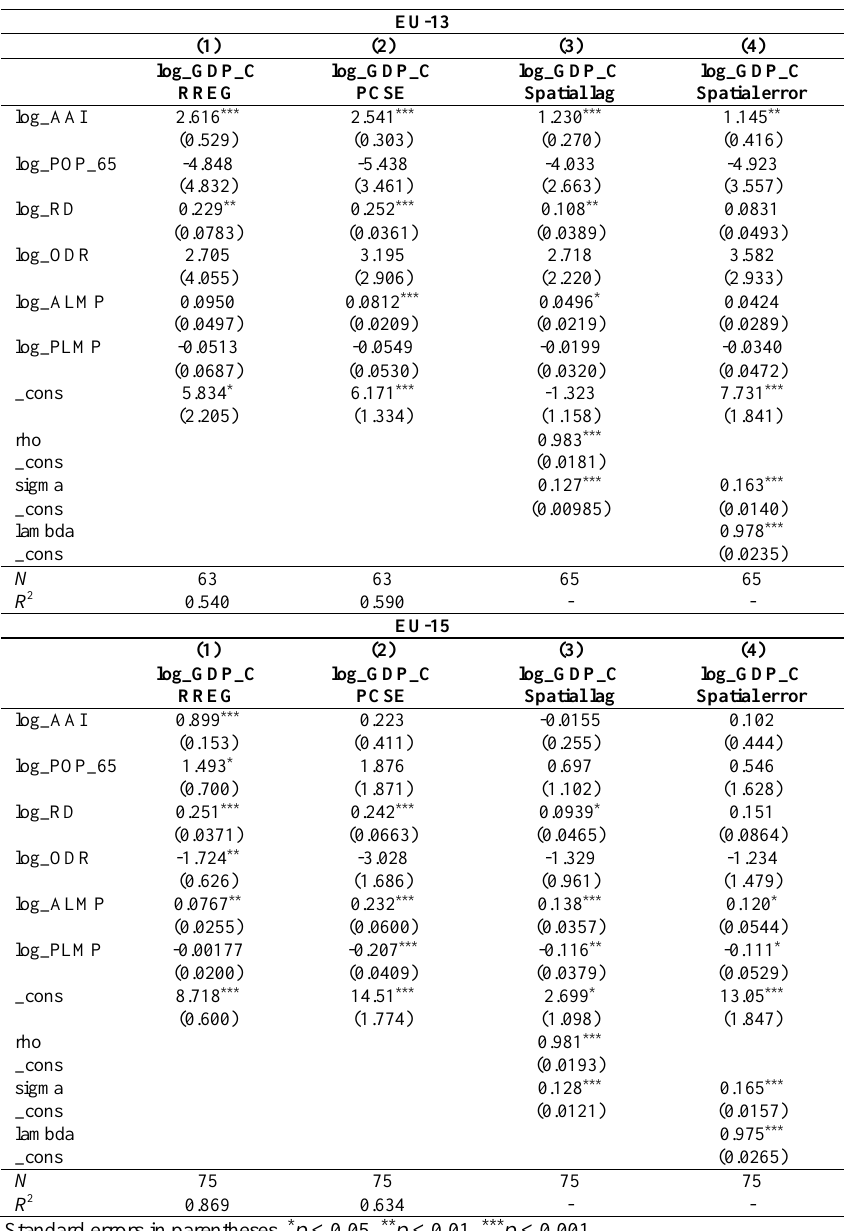
Table 4. Panel data analysis results, EU-13 and EU-15, data for the period (lapse of time): 2010, 2012, 2014, 2016,